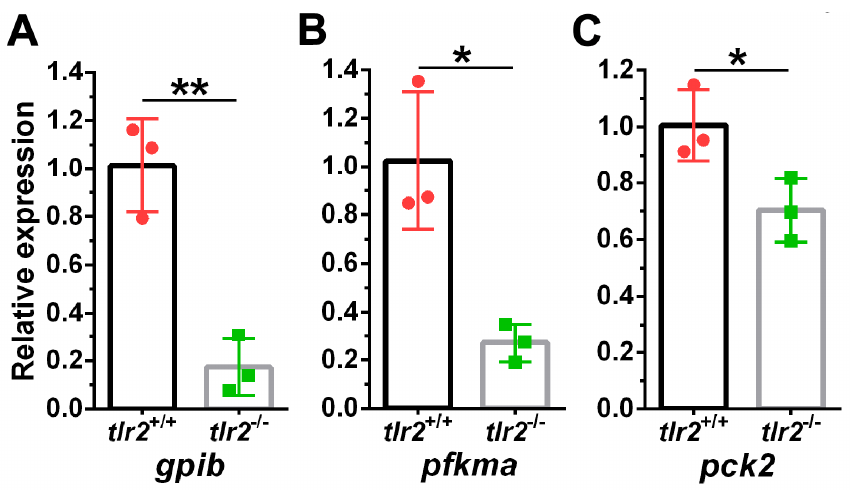
Figure 3. qPCR validation of genes from glycolysis and gluconeogenesis pathway. ( A ) gpib . ( B ) pfkma ( C ) pck2 . The information of the genes is shown in Table 1. * represents p < 0.05; ** represents p < 0.01. Table 1. Downregulated genes in glycolysis and gluconeogenesis pathways in tlr2 − / − versus tlr2 +/+ zebrafish larvae groups.